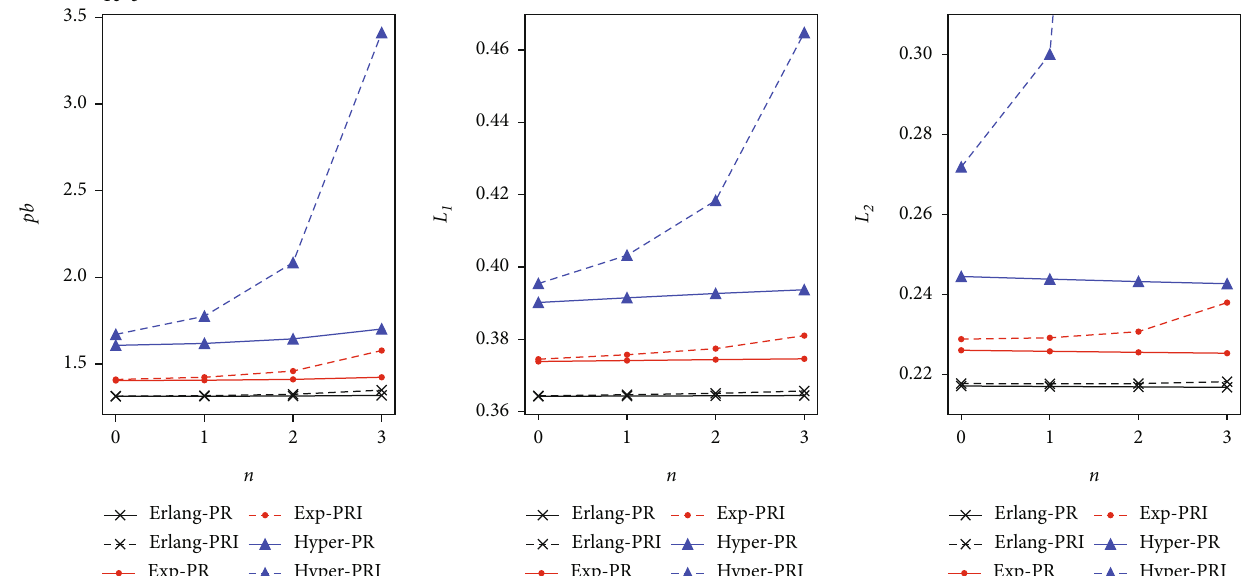
Figure 2: Performance measures for various values of n